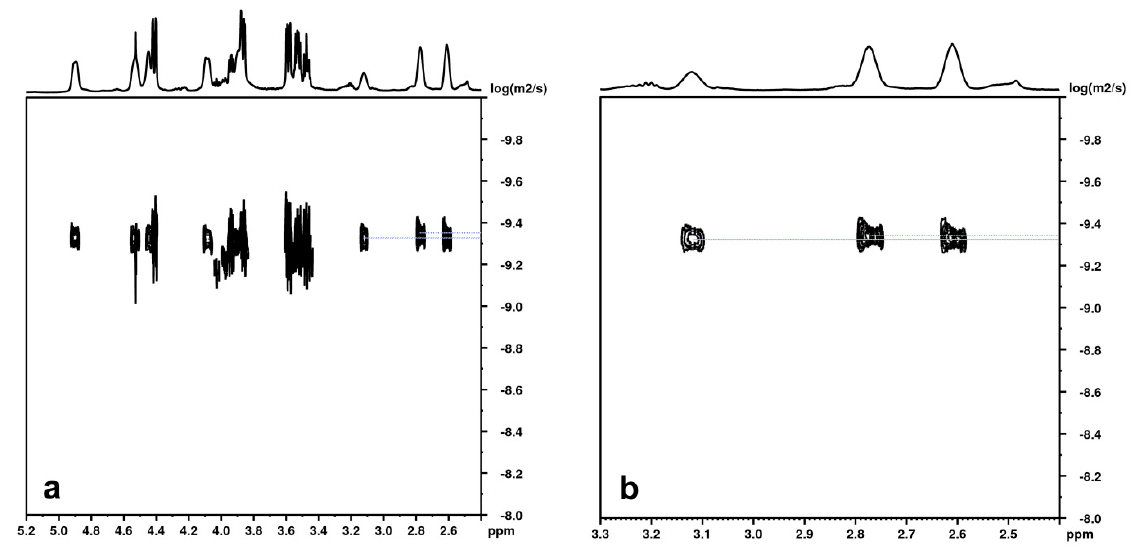
Figure 6. 1 H DOSY spectrum of the 2 M mixture of ligand 2c and BH 3 • SMe 2 in toluene-d 8 : ( a ) full spectrum, and ( b ) expanded area with the three sets of CH protons used for determination of the diffusion coefficients of the three complexes. The diffusion coefficients were calculated by fitting the diffusion profile of each signal (the normalized signal intensity as a function of the gradients’ strength) to a variant of the Stejskal–Tanner equation.